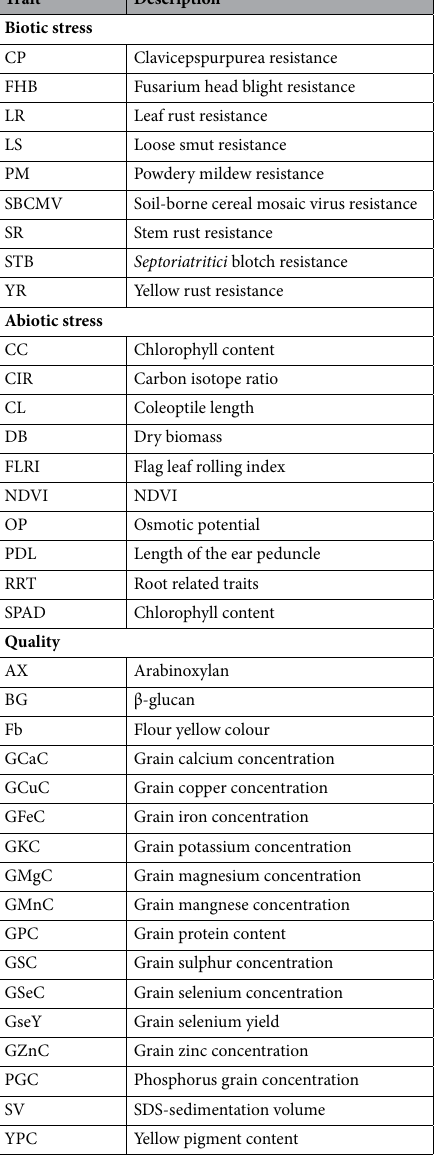
Table 1. Traits for biotic stress, abiotic stress and quality reported in the QTL